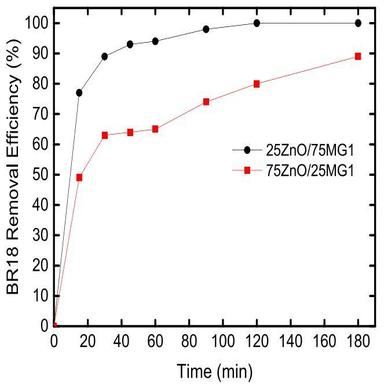
Photocatalytic degradation of BR18 dye for 25ZnO/75MG1 and 75ZnO/25MG1.